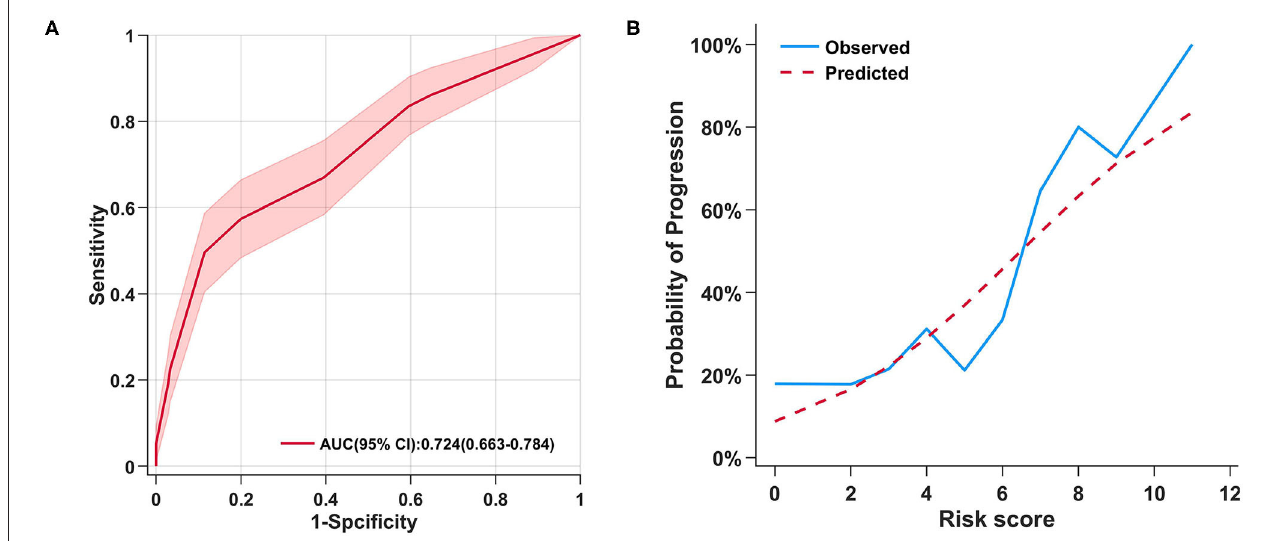
FIGURE 5 | (A) ROC curve for risk score as a predictor of severity of diabetic patients with COVID-19; (B) Observed vs. predicted probabilities of progression by risk